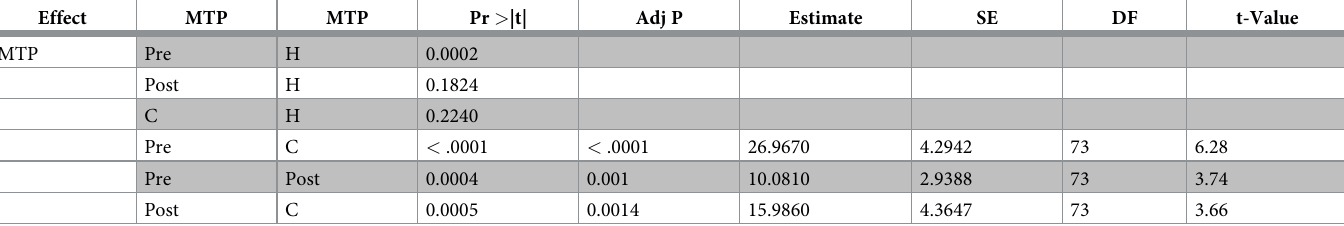
Table 2. Stimulated Th17-cells measured in EDTA-blood of dogs suffering from IVDH at three different sampling time points in comparison with Th17-cell levels of the healthy control group p-values of stimulated Th17-cells (absolute cell count/ μ l) in peripheral